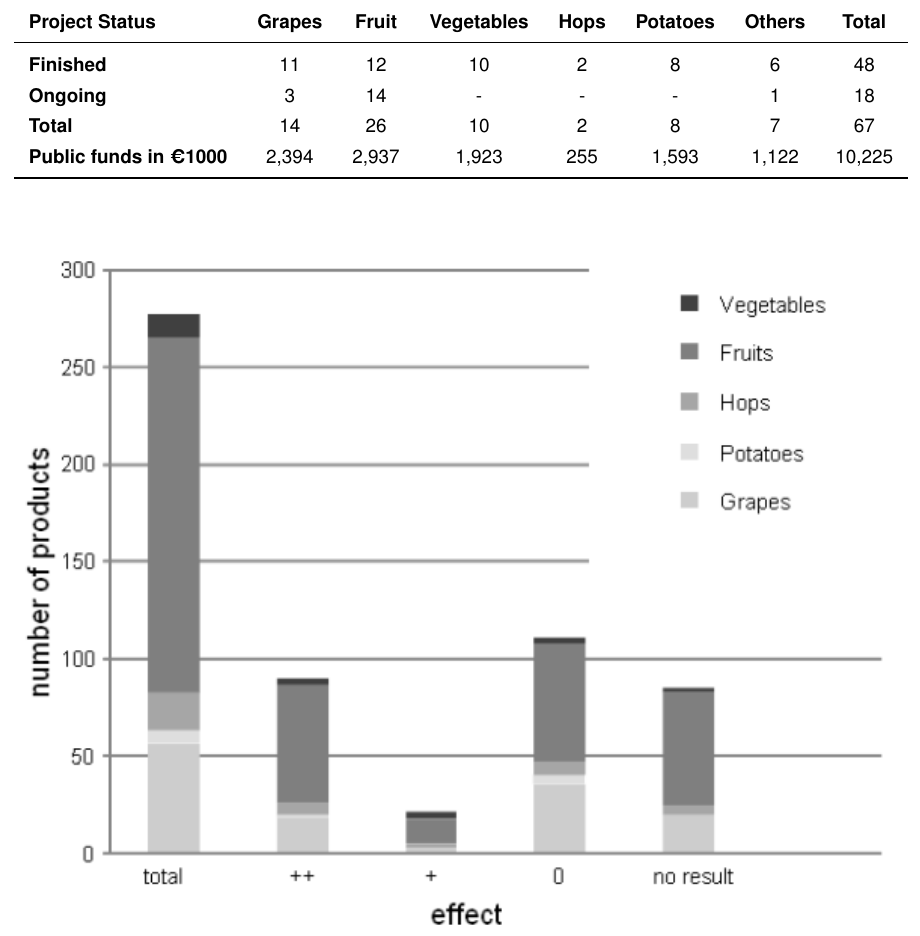
Figure 2. Number of copper alternative/replacement products field-tested under the B ¨OLN program and their effects in different crops. Symbols: ++ (significant effect), + (effective in the laboratory/greenhouse but not in the field), 0 (no